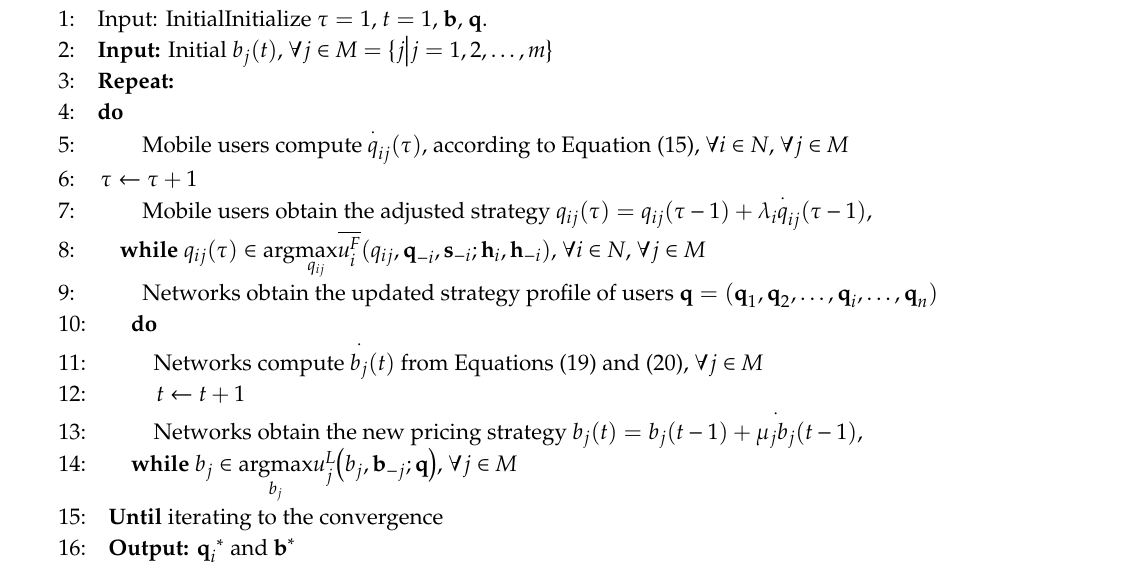
Algorithm 1 Stackelgerg Game-Based Distributed Resource Allocation